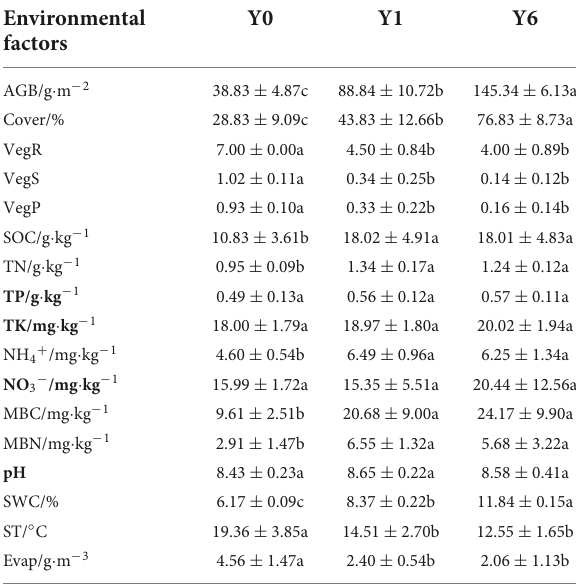
TABLE 1 Environmental factors in Y0, Y1, and Y6 soil